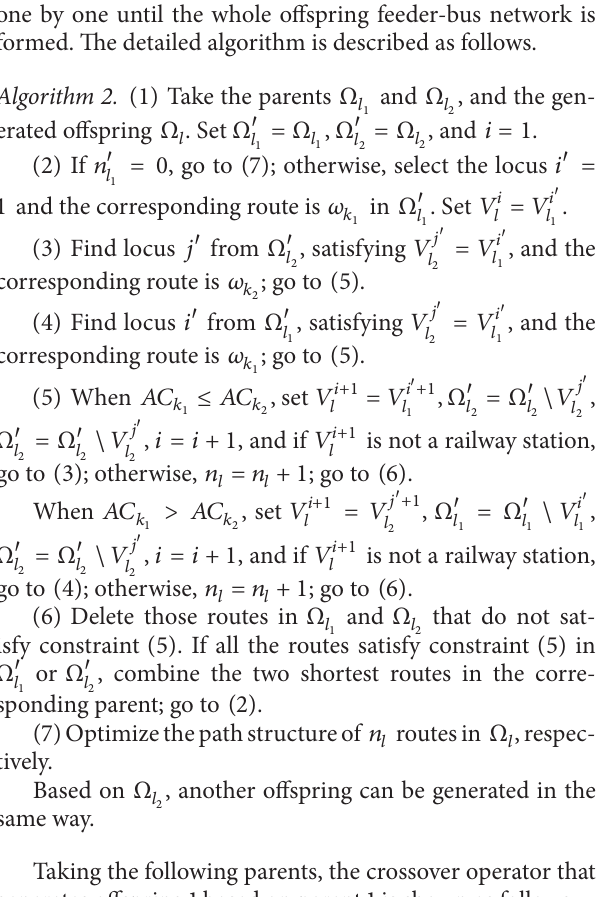
Algorithm 2. (1) Take the parents Ω 𝑙